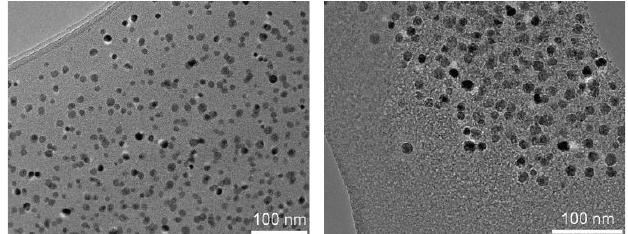
Table 1. Characteristics of the ATRP polymerizations (see Appendix A for details).